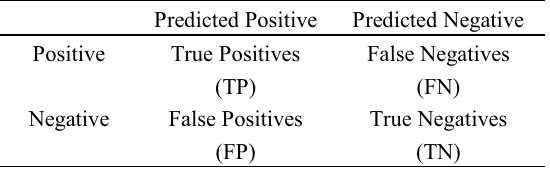
Table 1 Confusion matrix for performance evaluation Predicted